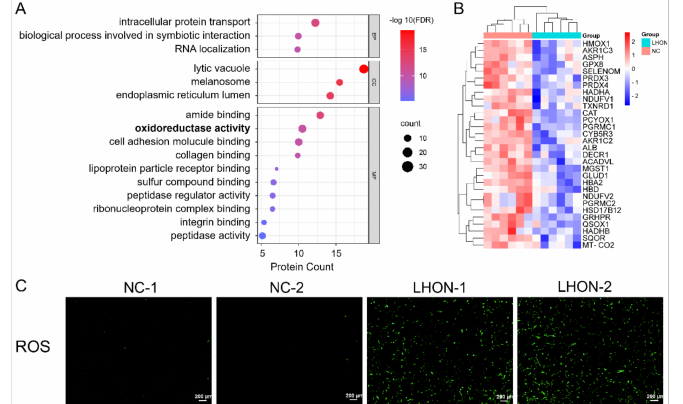
Figure 5. Downregulated oxidoreductase activity in LHON fibroblasts (m.G11778A). ( A ) Metascape enrichment of the downregulated DEPs was plotted. BP: biological process, CC: cellular component, MF: molecular function. Items were ranked by –log 10(FDR). ( B ) Heatmap showed downregulated differential proteins participated in oxidoreductase activity. ( C ) ROS level was detected in LHON and control fibroblasts. Scale bars represent 200 µ m.